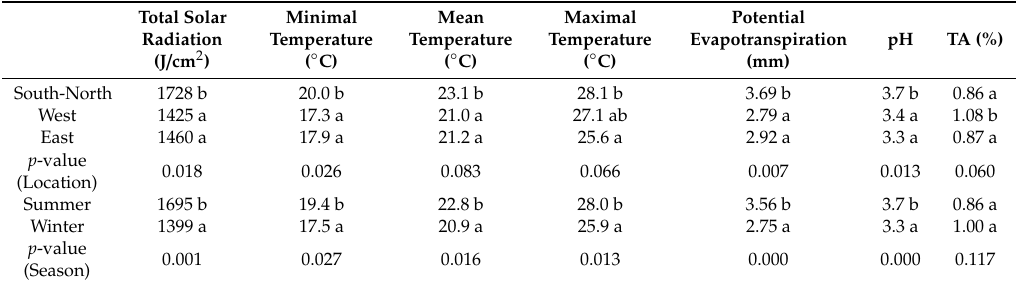
Table 3. Meteorological data and influence of crop location and harvest season on pineapple juice physicochemical characteristics. For the same column, di ff erent letters indicate significant di ff